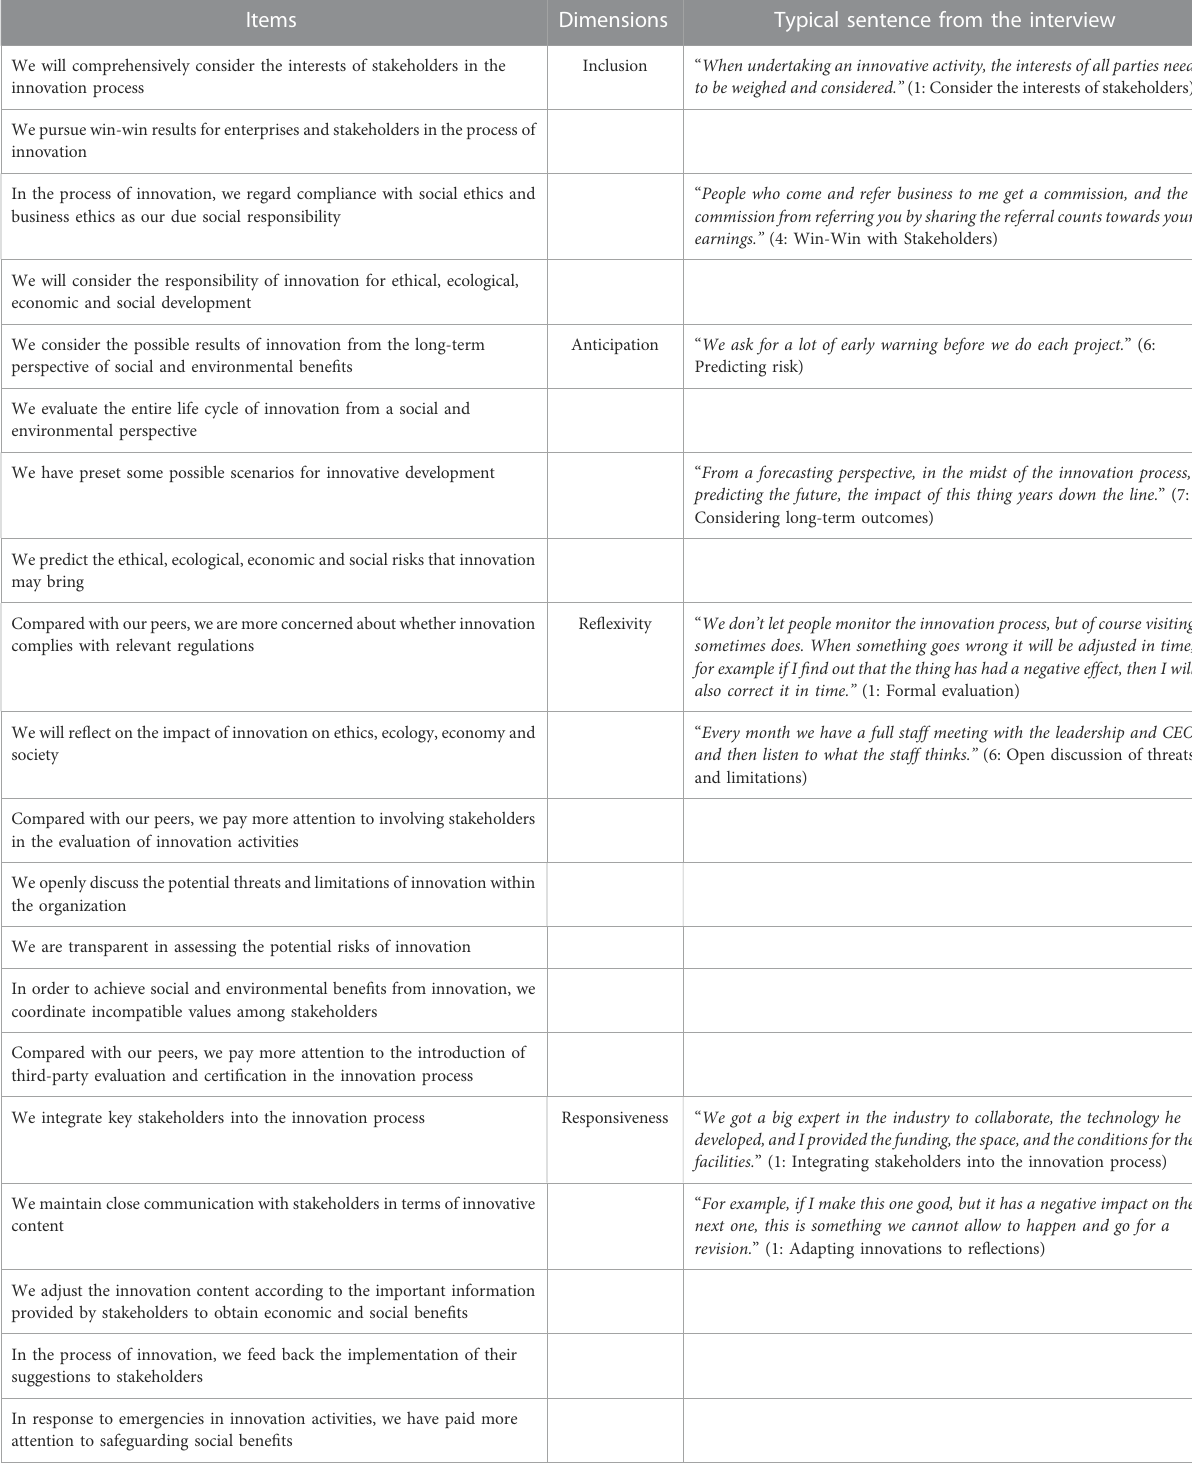
TABLE 4 The items and dimensions of corporate responsibility